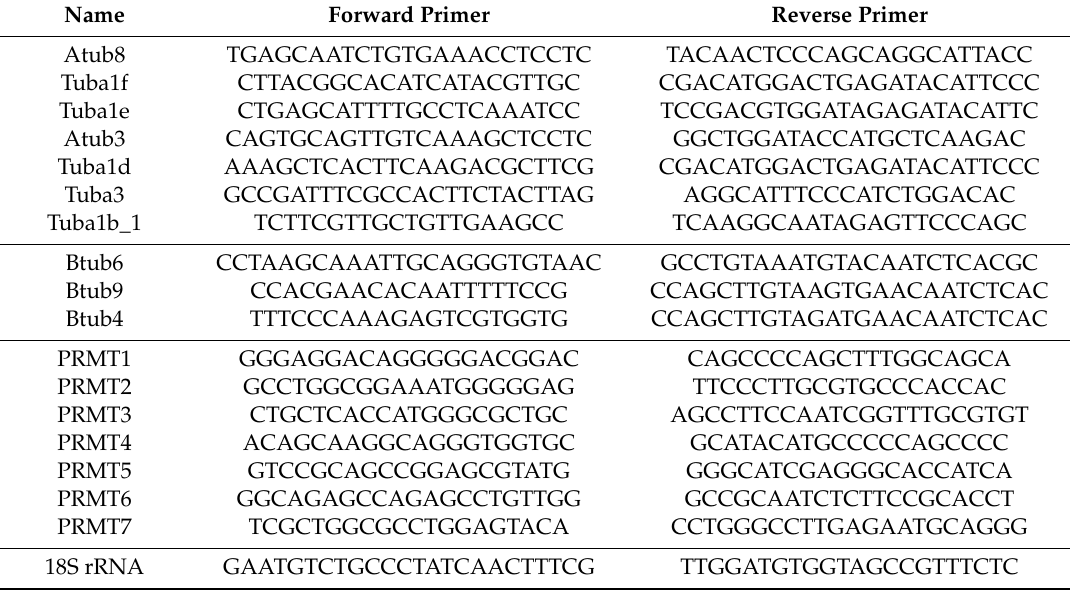
Table 9. Oligonucleotides used as primers for the